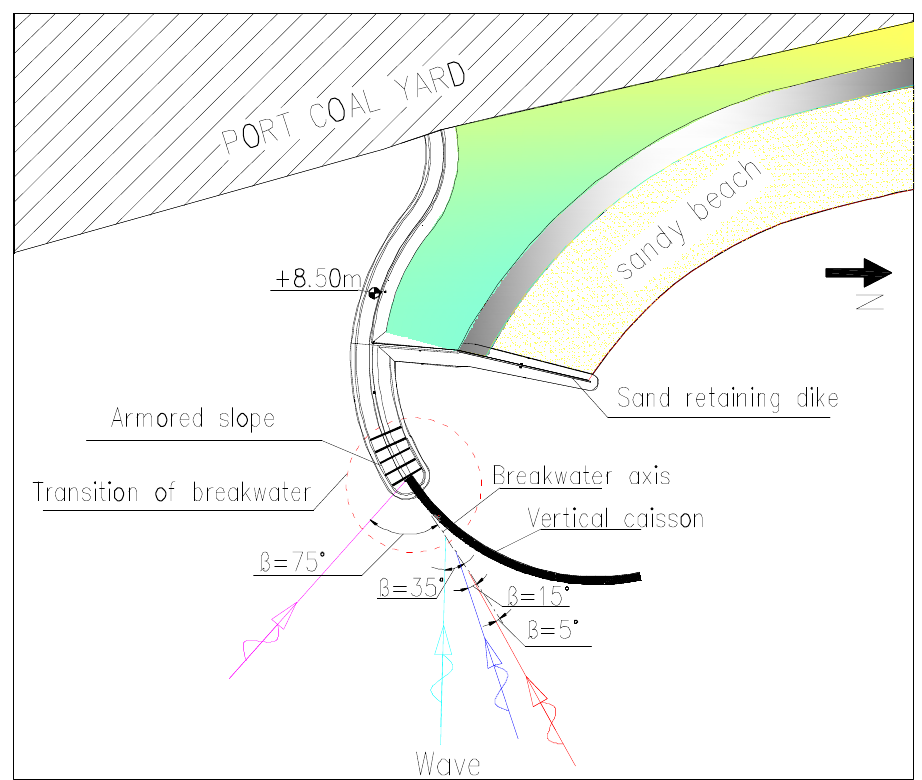
Figure 2. Layout plan of the transition of breakwater project.